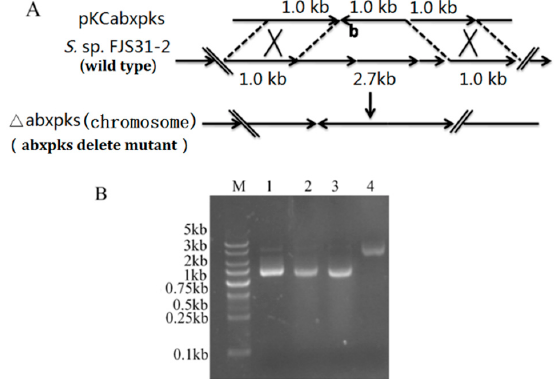
Table 1. Homologous analysis of abx gene cluster from Streptomyces strains.